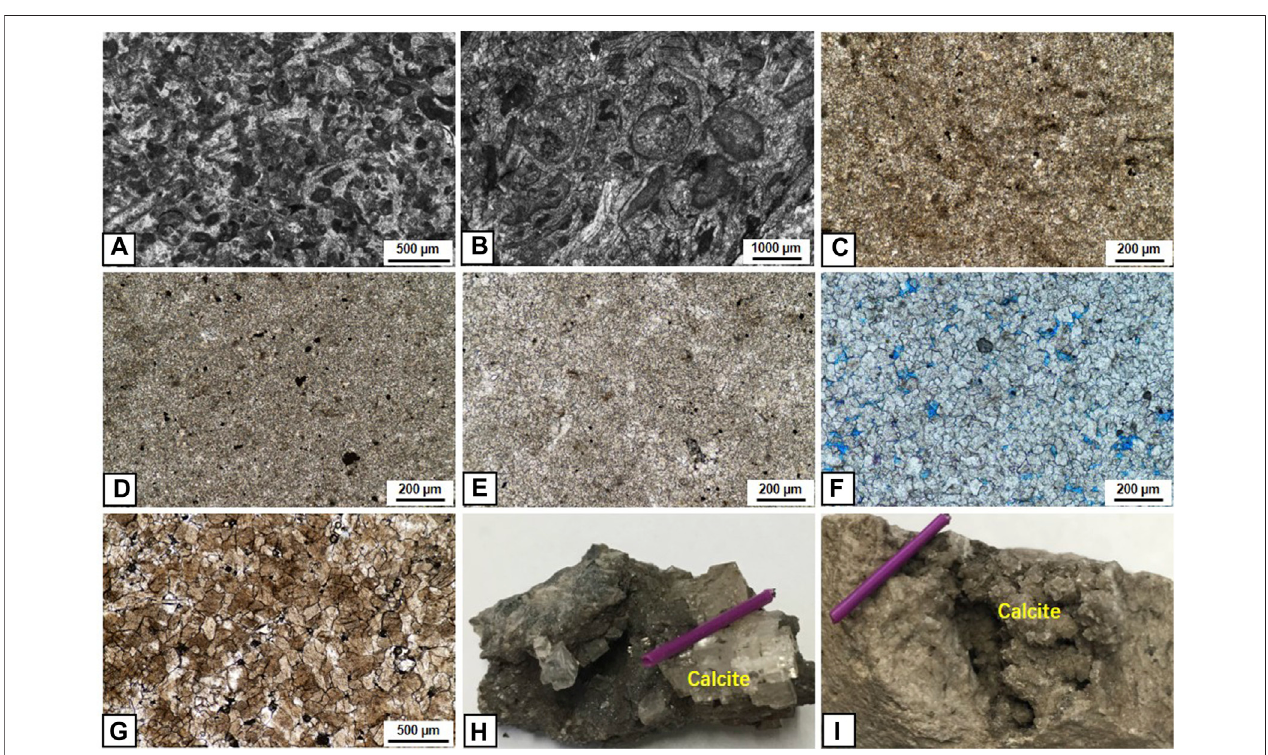
FIGURE 2 | (A – G) Thin-section photomicrographs of limestone and dolostone samples, and (H,I) photographs of calcite cements. (A) Sample D1, XBX outcrop, bioclasticlimestone. (B) Sample L56, well PG6, 5383.1 m, P 2 c, bioclastic limestone. (C) Sample L62, well MB3, 4014.0 m, T 1 f, micritic limestone. (D) SampleD83, well MB4, 3892.5 m, T 1 f, micritic dolostone. (E) Sample D90, well PG2, 4878.0 m, T 1 f, micritic dolostone. (F) Sample D89, well PG12, 6007.0 m, T 1 f, fi ne crystallized dolostone. (G) Sample D99, well PG6, 5339.0 m, P 2 c, medium crystallized dolostone. (H) Sample Cem8, well MB3, P 2 c, 4394.6 m, coarse calcite cements (the lengthofthesmallpurplestickis2.0 cm). (I) SampleCem5,wellDW102,4825.0 m,T 1 f,coarsecalcitecementsinvugsindolostone.Note:thewellsMB3,MB4,DW102, PG2, PG6 and PG12 are all located in the Puguang gas fi